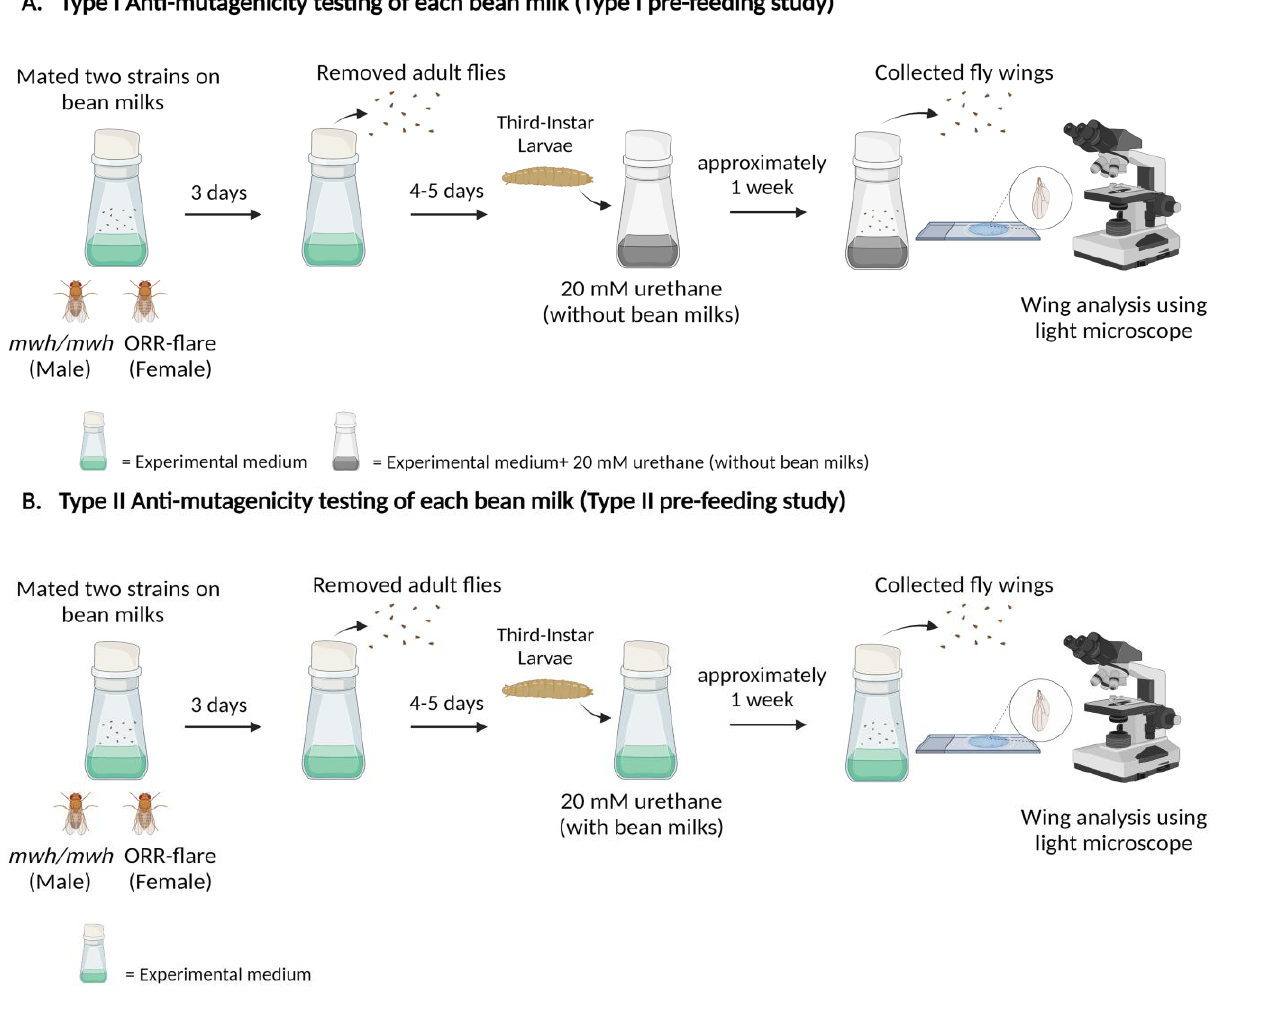
Figure 4. Experimental design of the pre-feeding study for anti-mutagenicity testing: ( A ) Pre-feeding study type I; crossed adult flies were fed on the experimental medium containing only bean milk, and the third instar larvae were transferred to the experimental medium containing only 20 mM urethane. Wings were collected and analyzed for mutant spots, ( B ) Pre-feeding study type II; crossed adult flies were fed on the experimental medium containing only bean milk, and the third instar larvae were transferred to the experimental medium containing each bean milk + 20 mM urethane. Wings were collected and analyzed for mutant spots.